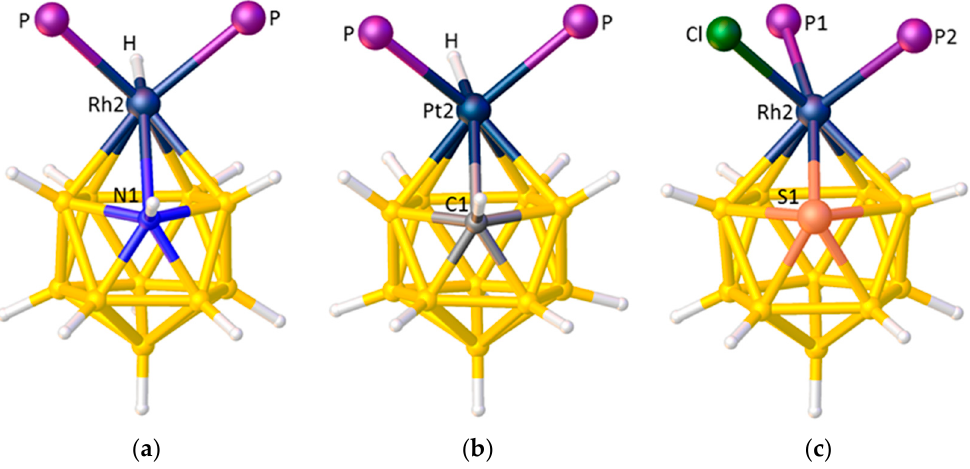
Figure 15. ( a ) The structure of [2,2-(PPh 3 ) 2 -2-H- closo -2,1-RhNB 10 H 11 ]. Ph groups omitted for clarity; ( b ) The structure of [2,2-(PEt 3 ) 2 -2-H- closo -2,1-PtCB 10 H 11 ]. Et groups omitted for clarity; ( c ) The structure of [2,2-(PMe 2 Ph) 2 -2-Cl- closo -2,1-RhSB 10 H 10 ]. Ph and Me groups omitted for clarity. Rh2 − P1(| θ | = 165.7°) 2.3286(5), Rh2 − P2(| θ | = 62.6°) 2.3992(5) Å. Here θ is de fi ned by the torsion angle P − Rh2 − A −